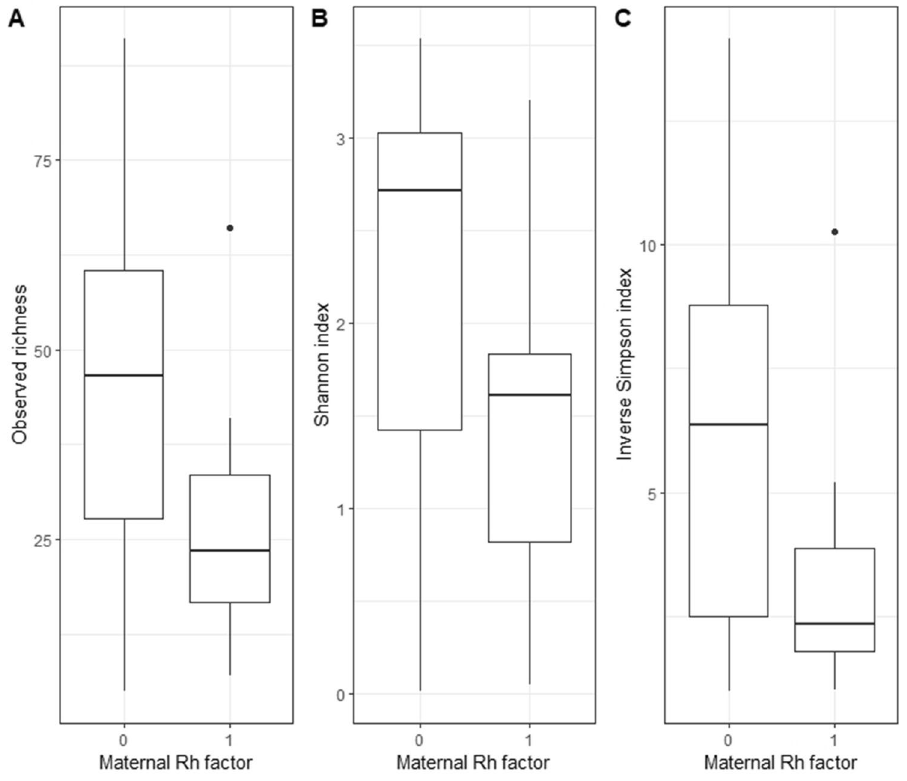
Figure 1. Box plots of alpha diversity by maternal Rh factor. The three panels ( a ), ( b ) and ( c ) report the observed richness index, Shannon index and Inverse Simpson index respectively.